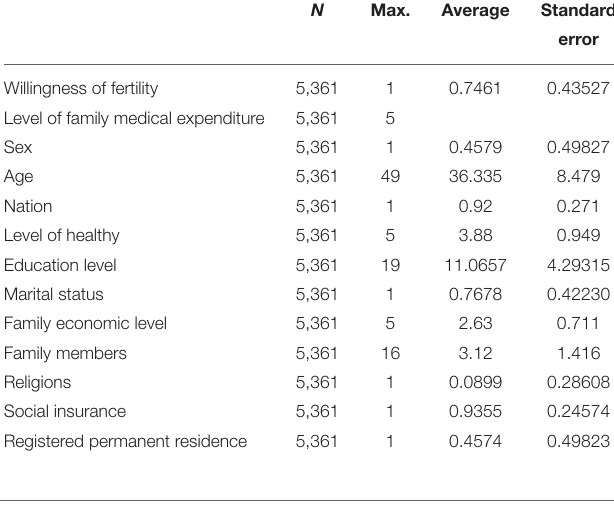
TABLE 1 | Description of independent